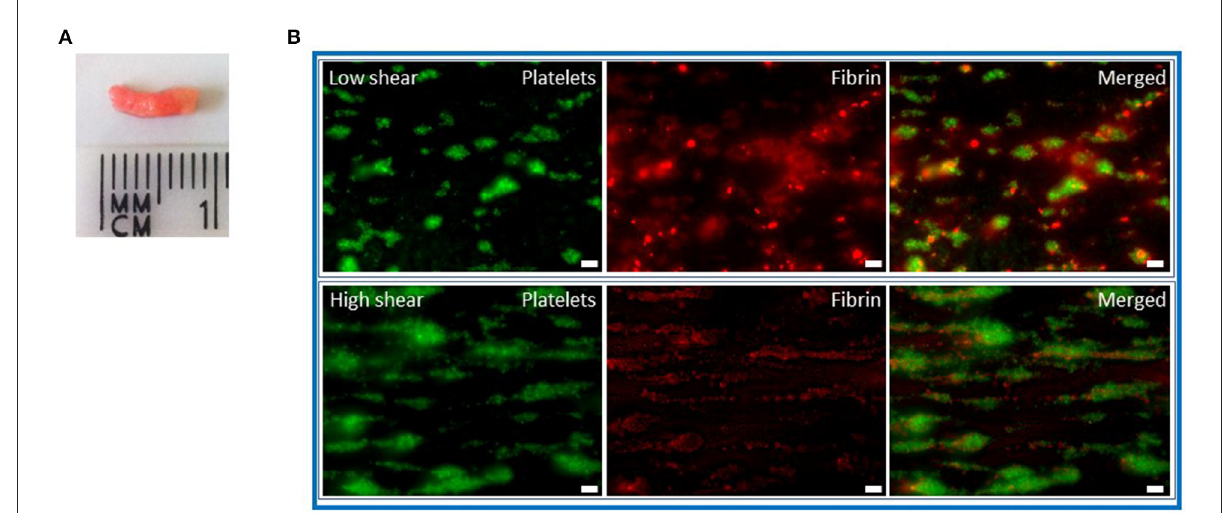
FIGURE2 Whole blood thrombi under flow. (A) Chandler model thrombi formed from citrated whole blood that was recalcified (10.9mM CaCl 2 ). Thrombi were formed under rotation at a constant speed of 30 rpm for 90min before being removed and washed in 0.9% saline. The platelet-rich white head is visible. (B) Recalcified whole blood thrombi were formed on a collagen (100 ng) and tissue factor (300 pM) surface in Cellix biochips. Thrombi formed under high shear (1,000 s − 1 ) are more platelet-rich with less fibrin than those formed at low shear (250 s − 1 ). DiOC6 (0.5 µ g/ml) was included to label platelets (green) and fibrinogen-AF546 (75 µ g/ml) added (red). Scale bars represent 10 µ